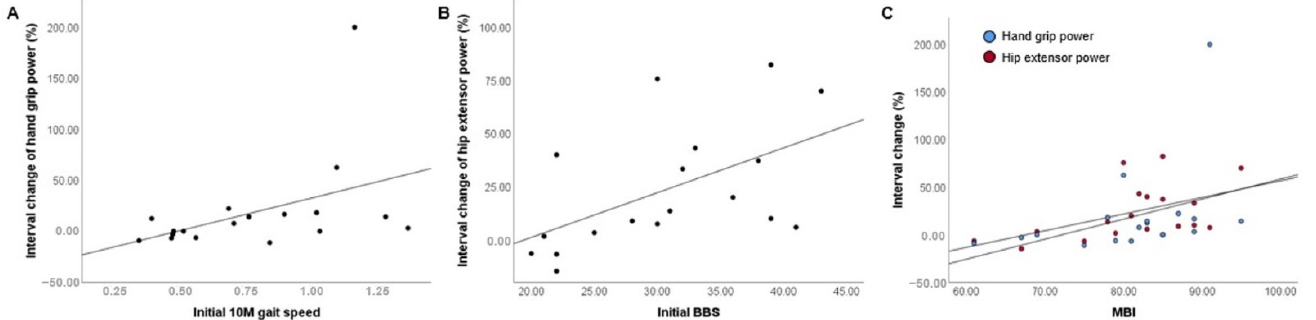
Figure 2. Scatter plots for initial values of physical assessment and significantly improved variables. ( A ) Scatter plot for the first 10 m gait speeds and hand grip power interval changes. ( B ) Scatter plot for initial BBS and hip extensor power interval change. ( C ) Scatter plot for initial MBI and hip extensor power interval